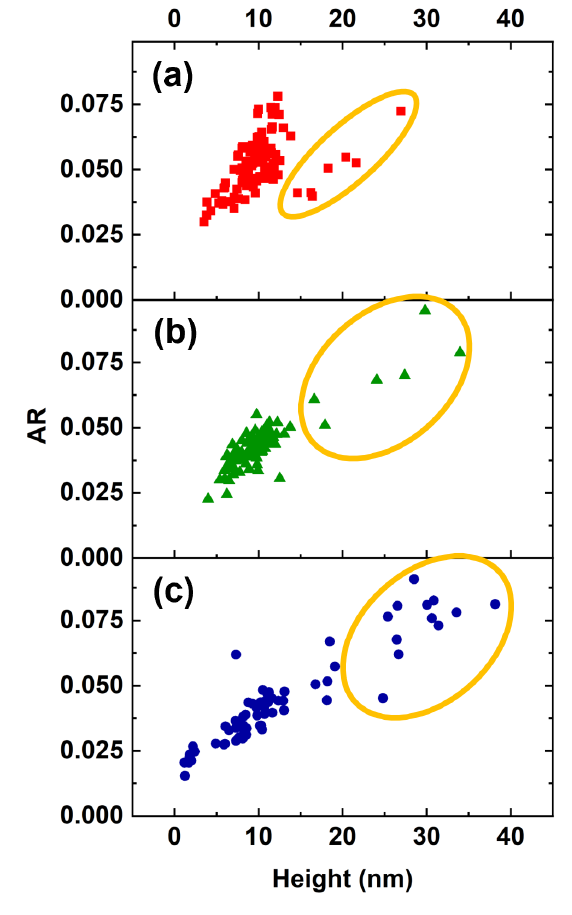
Figure 6. Aspect ratio as a function of the height measured on the single QDs for Sample S1 ( a ), Sample S2 ( b ), and Sample S3 ( c ). The data outlined in orange were measured on plastically relaxed Group B QDs. These QDs grew in density and height with increasing CL